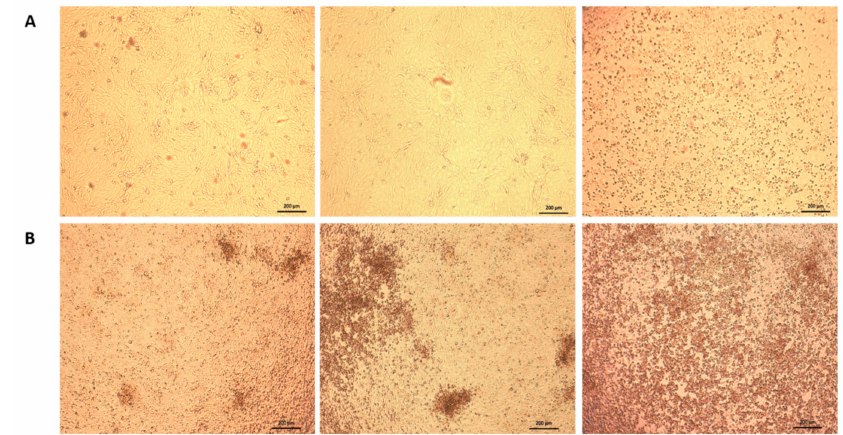
Figure 3. Comparison of BTV-8 and BTV-25-GER2018 virus neutralization. Virus neutralization results of ( A ) methodical control with BTV-8 virus and BTV-8 positive serum (1:10, 1:80 and 1:1280) ( B ) cELISA positive serum of a BTV-25-GER2018 field infected goat (1:10, 1:80 and